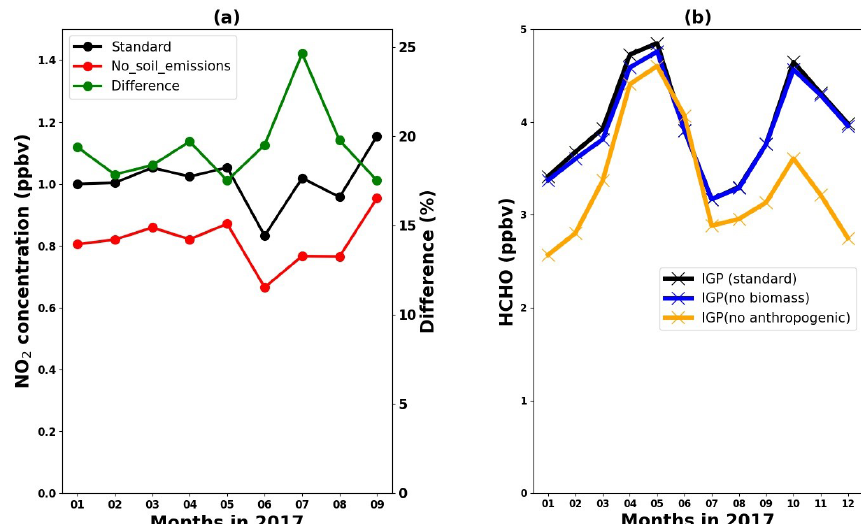
Figure 16. (a) Monthly mean NO 2 concentrations at Phimai were estimated from the standard (black) and L1_NO 2 (red) simulations. The soil NO x emissions are switched off in the LI_NO 2 simulation. The green line represents the percentage difference between the two simulations. (b) Seasonal variations in the HCHO concentrations in the IGP region, obtained from the standard, L1_HCHO (pyrogenic VOC emissions switched off), and L2 simulations (anthropogenic VOC emissions switched off). The simulations for 2017 are shown and analyzed. Daytime values from 09:00–12:00 and 09:00–15:00LT were selected for Phimai and the IGP,